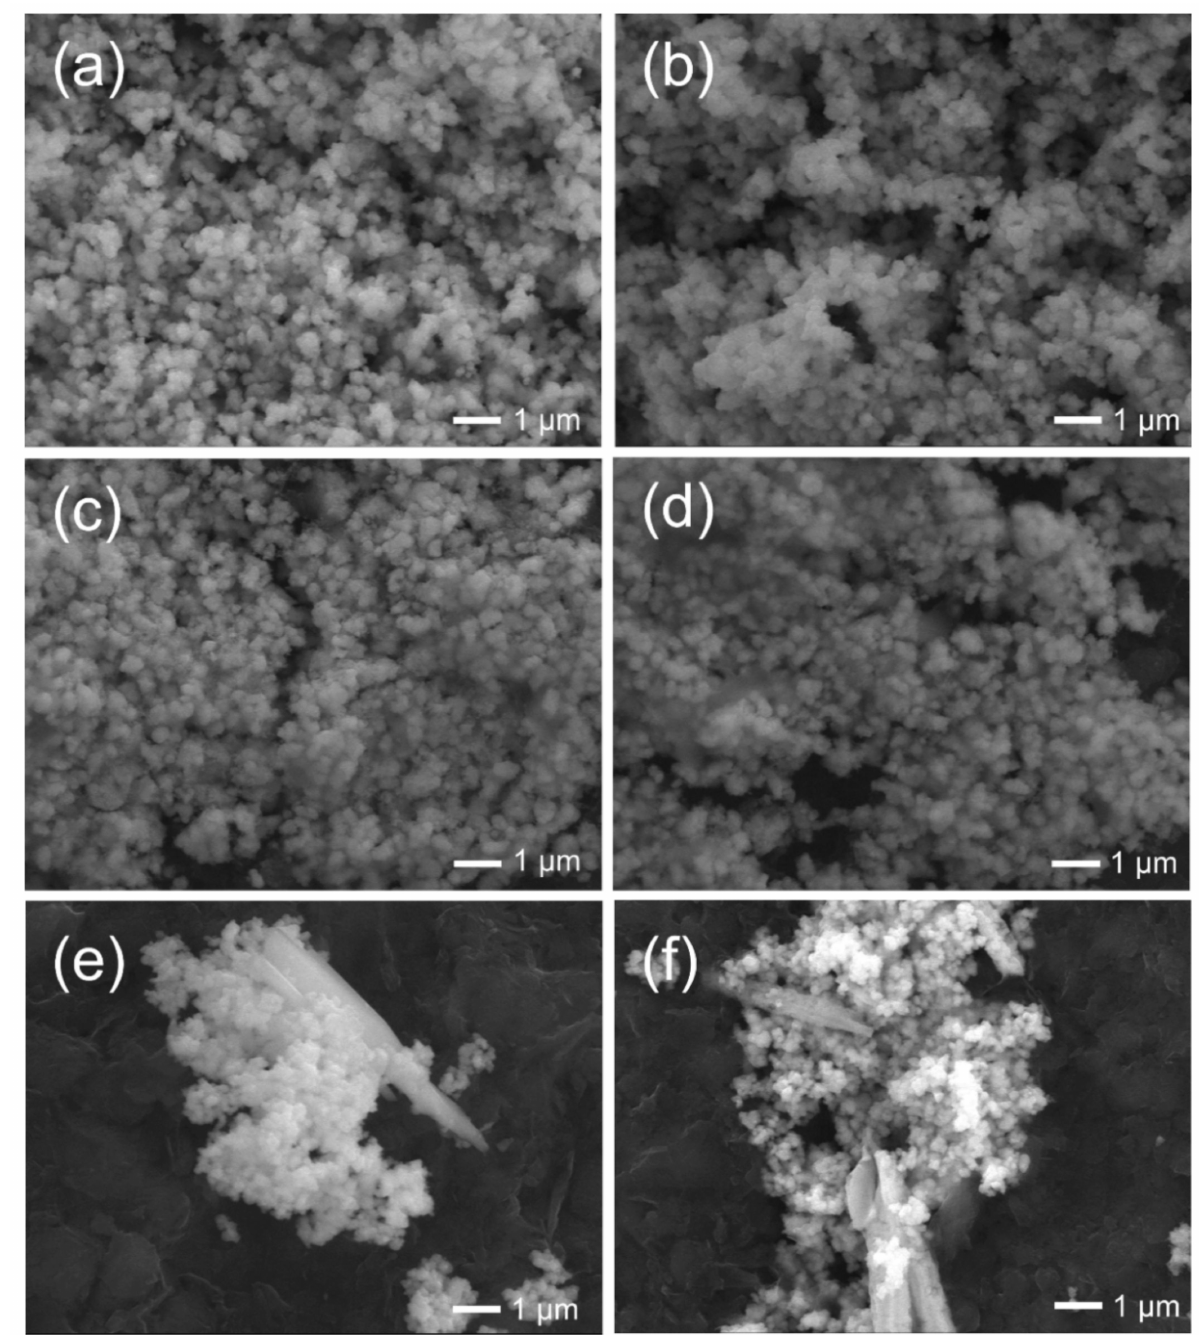
Figure 7. SEM images of ( a ) CeO 2 -NS-NA 2 h before calcination; ( b ) CeO 2 -NS-NA 2 h; ( c ) CeO 2 -NS- NA 4 h before calcination; ( d ) CeO 2 -NS-NA 4 h ( e ) CeO 2 -NS-NA before calcination, and ( f ) CeO 2 -